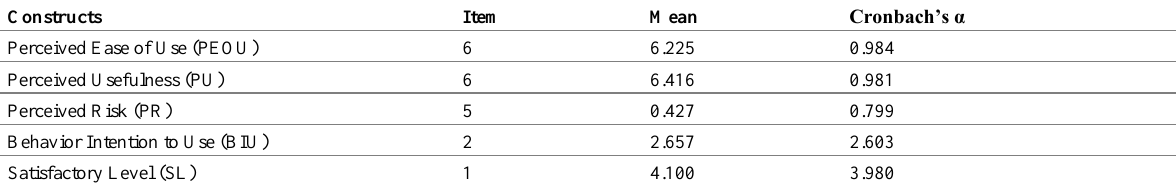
Table 2: Mean and scale reliability of each construct